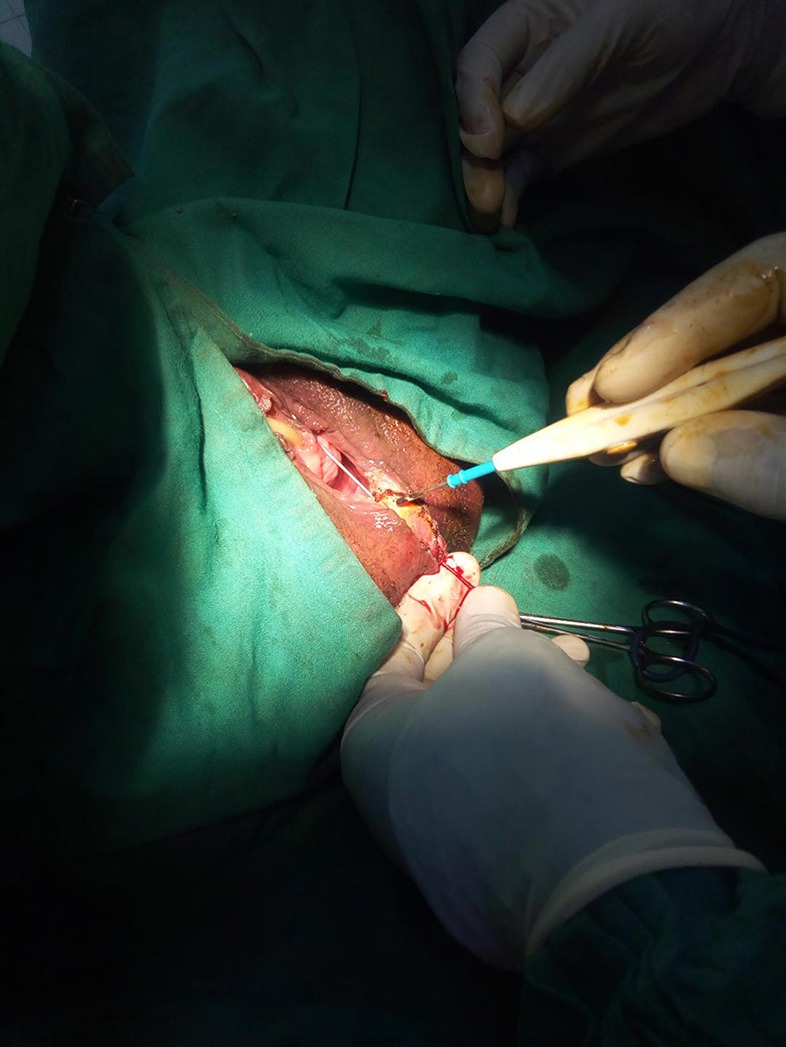
Perineal fistulotomy converting fistula to a third degree tear.